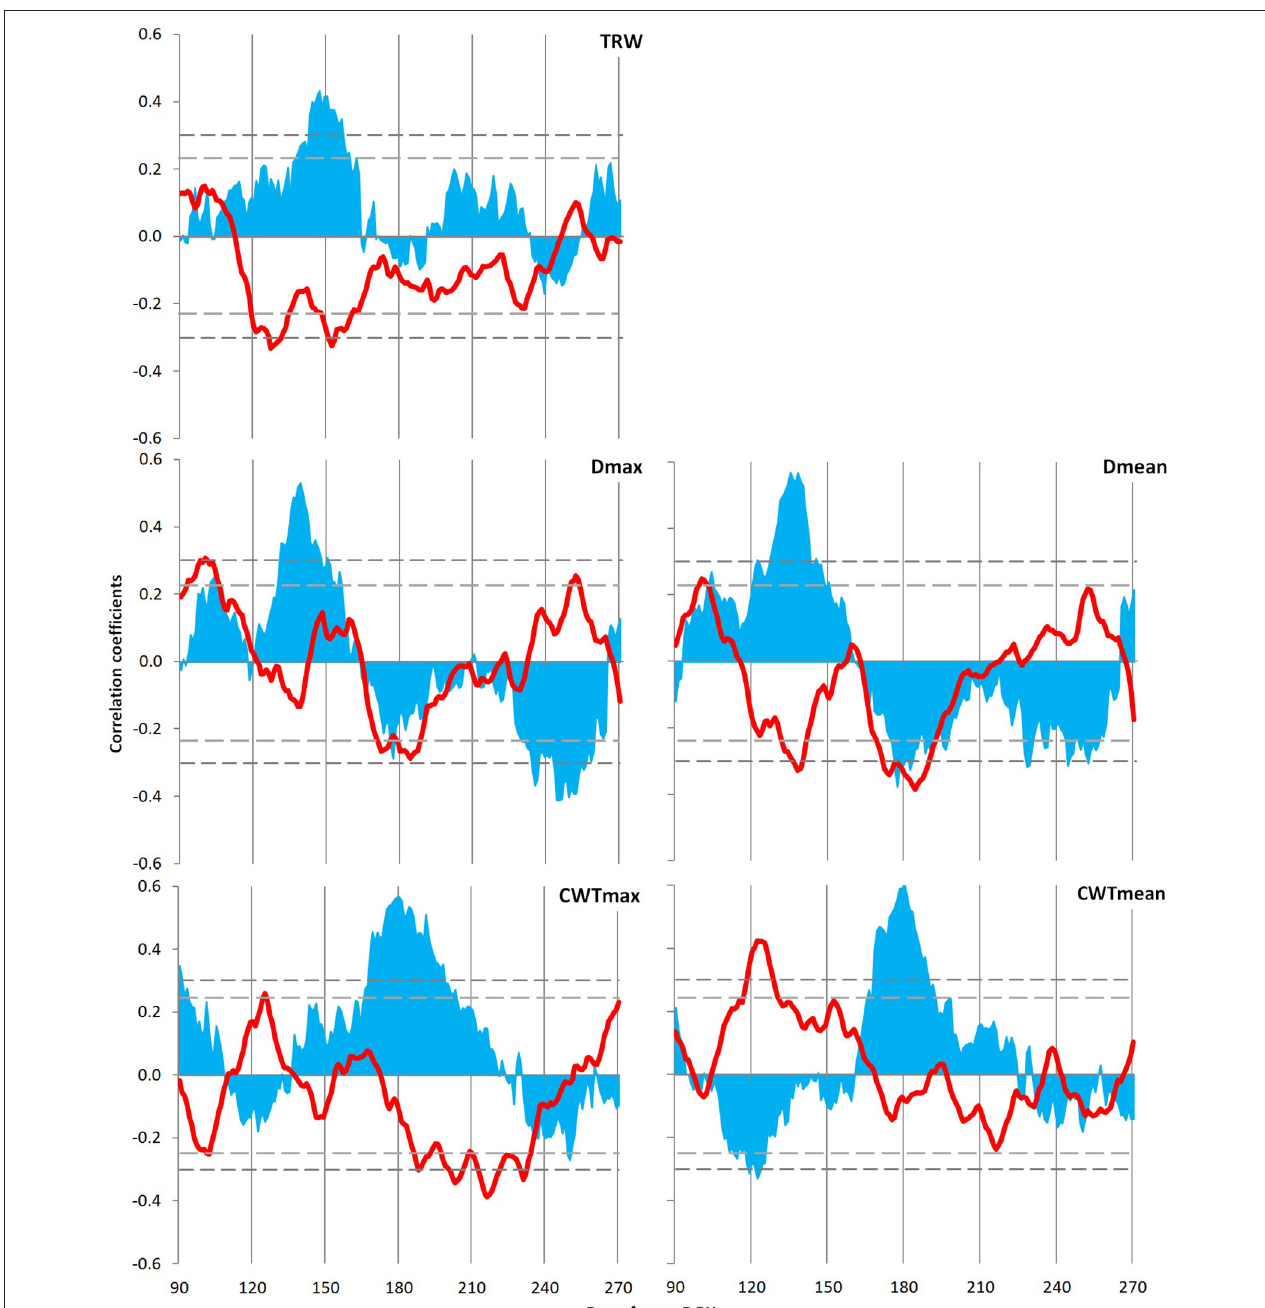
FIGURE 6 | Climatic response of tree ring characteristics of the Scots pine: tree ring width ( TRW ), maximum ( D max ) and mean ( D mean ) values of cell radial diameter, and maximum ( CWT max ) and mean ( CWT mean ) values of cell wall thickness in the tree ring. Plots show correlations of indexed local chronologies with moving series of temperature (red lines; 1966–2008) and precipitation (blue areas; 1936–2008), calculated from daily data with a 21-day window and 1-day step. The horizontal dashed lines show the significance level p = 0.05 for correlations with temperature (short dashes) and precipitation (long dashes).